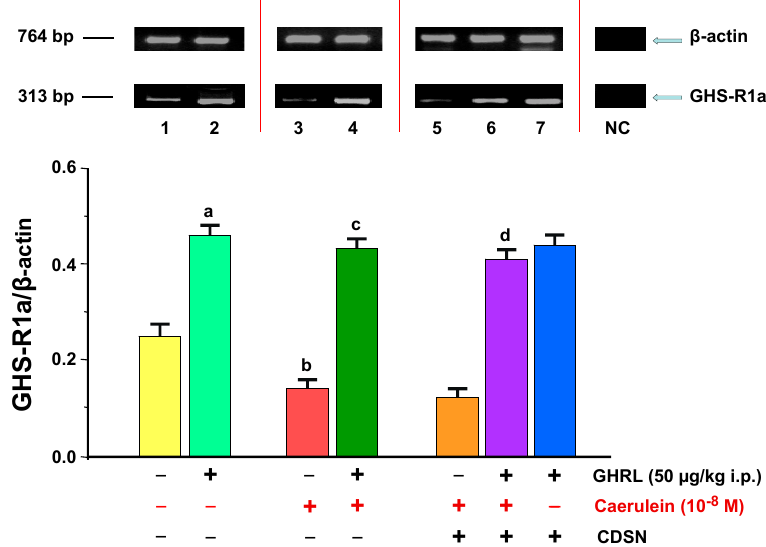
Figure 1. Analysis of the growth hormone secretagogue receptor 1a (GHS-R1a) gene expression determined by reverse transcriptase-polymerase chain reaction (RT-PCR) and densitometric analysis of GHS-R1A/ β -actin mRNA ratio in pancreatic acinar cells: (line 1) acinar cells obtained from control sensory nerves (SN)-intact rats treated with saline, after isolation, acinar cells incubated in caerulein-free solution; (line 2) acinar cells obtained from SN-intact rats treated with ghrelin (GHRL), after isolation, acinar cells incubated in caerulein-free solution; (line 3) acinar cells obtained from SN-intact rats treated with saline, after isolation, acinar cells incubated in solution containing caerulein at a concentration of 10 − 8 M; (line 4) acinar cells obtained from SN-intact rats treated with GHRL, after isolation, acinar cells incubated in solution containing caerulein at a concentration of 10 − 8 M; (line 5) acinar cells obtained from rats with capsaicin deactivation of SN (CDSN) and treated with saline, after isolation, acinar cells incubated in solution containing caerulein at a concentration of 10 − 8 M; (line 6) acinar cells obtained from rats with CDSN and treated with GHRL, after isolation, acinar cells incubated in solution containing caerulein at a concentration of 10 − 8 M; (line 7) acinar cells obtained from rats with CDSN and treated with GHRL, after isolation, acinar cells incubated in caerulein-free solution. NC = negative control. Reference gene: β -actin. a,b p < 0.05 compared to control acinar cells obtained from rats with intact SN (line 1); c p < 0.05 compared to acinar cells stimulated with caerulein after isolation from SN-intact rats treated with saline (line 3); d p < 0.05 compared to acinar cells stimulated with caerulein after isolation from rats with CDSN and treated with saline (line 5). In each experimental group, the number of observations was at least